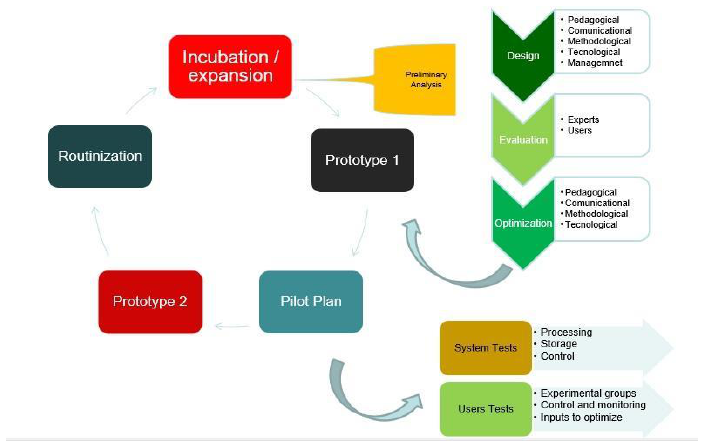
Figure 1 . Incremental model prototype (Careaga Butter, Badilla Quintana, & Sepúlveda Valenzuela,